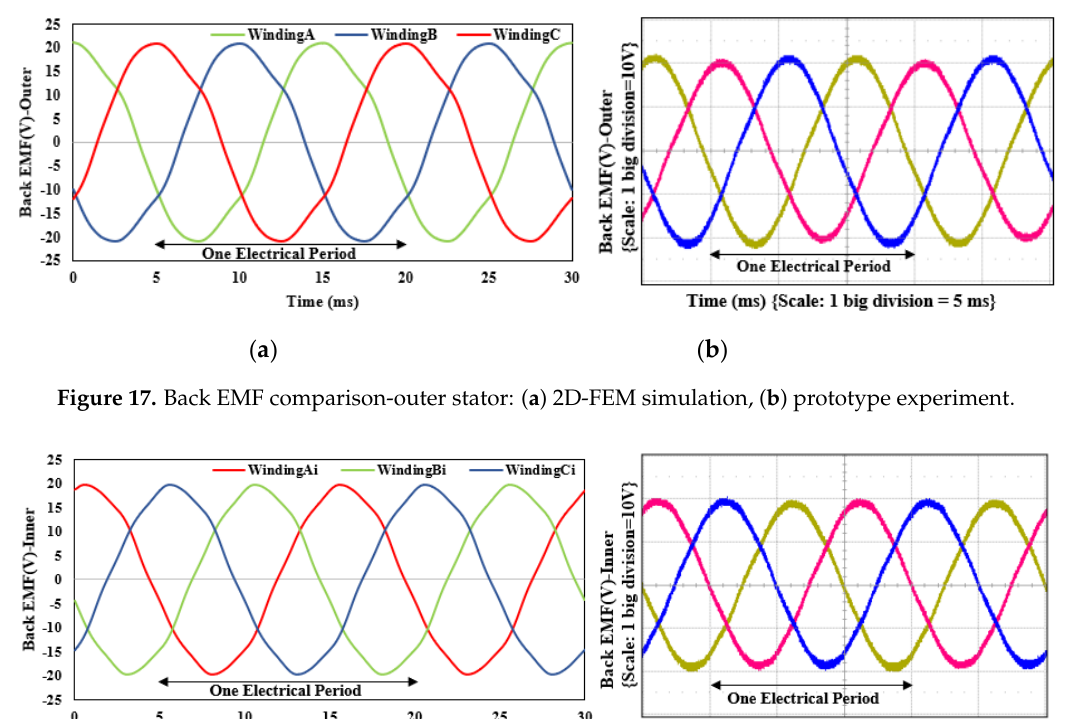
Figure 18. Back EMF comparison-inner stator: ( a ) 2D-FEM simulation, ( b ) prototype experiment.